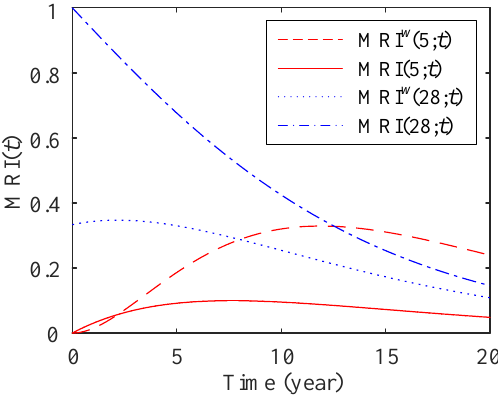
Figure 13. MRI of components (5 and 28) with and without